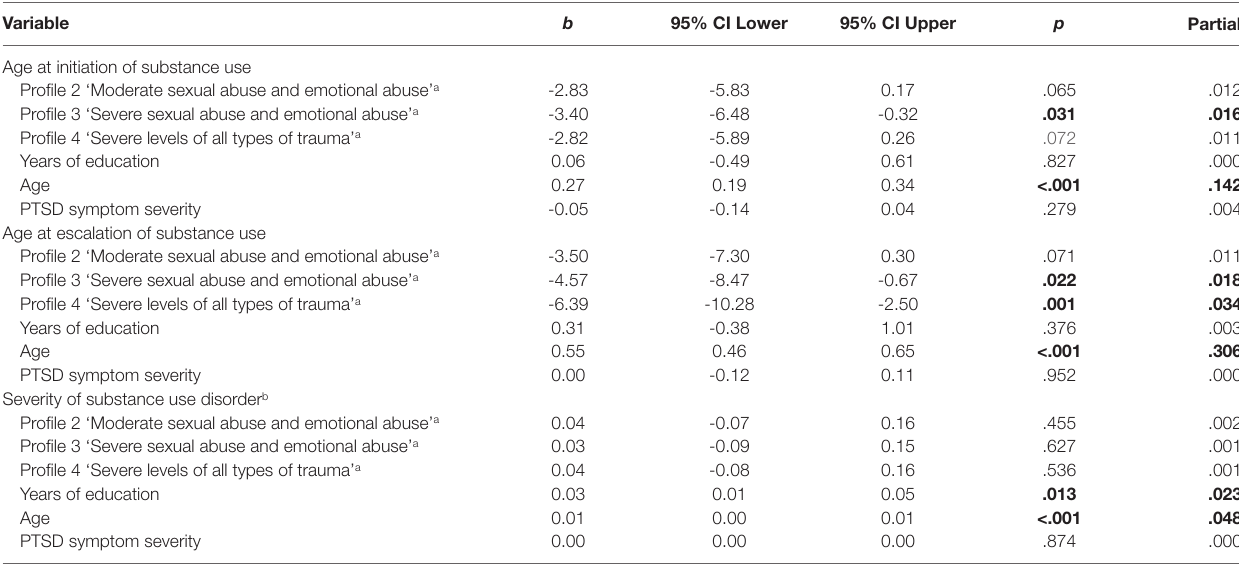
TABLE 3 | Effects of childhood trauma profiles on addiction characteristics (N = 343).